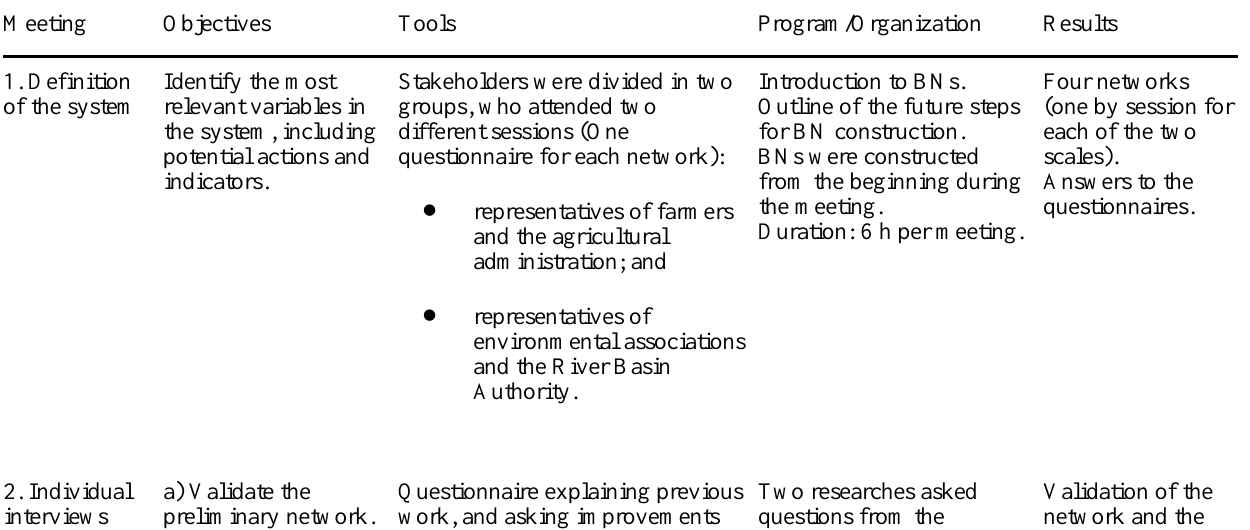
Table 2 . Description of the participatory process developed using Bayesian networks in the Upper Guadiana Basin (May 2007-April